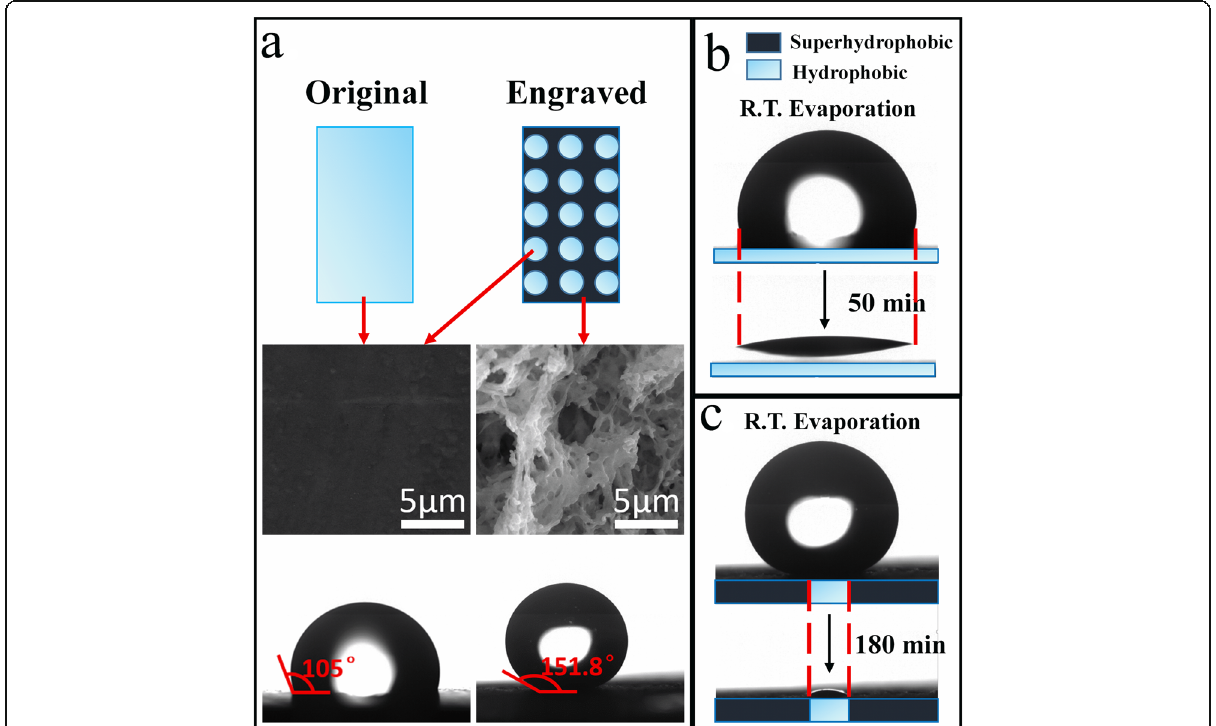
Fig. 2 a The SEM images of substrate surface about original PTFE and engraved PTFE and corresponding static contact angle images; b Evaporation profiles of solution on the original PTFE; c Evaporation profiles of solution on the engraved